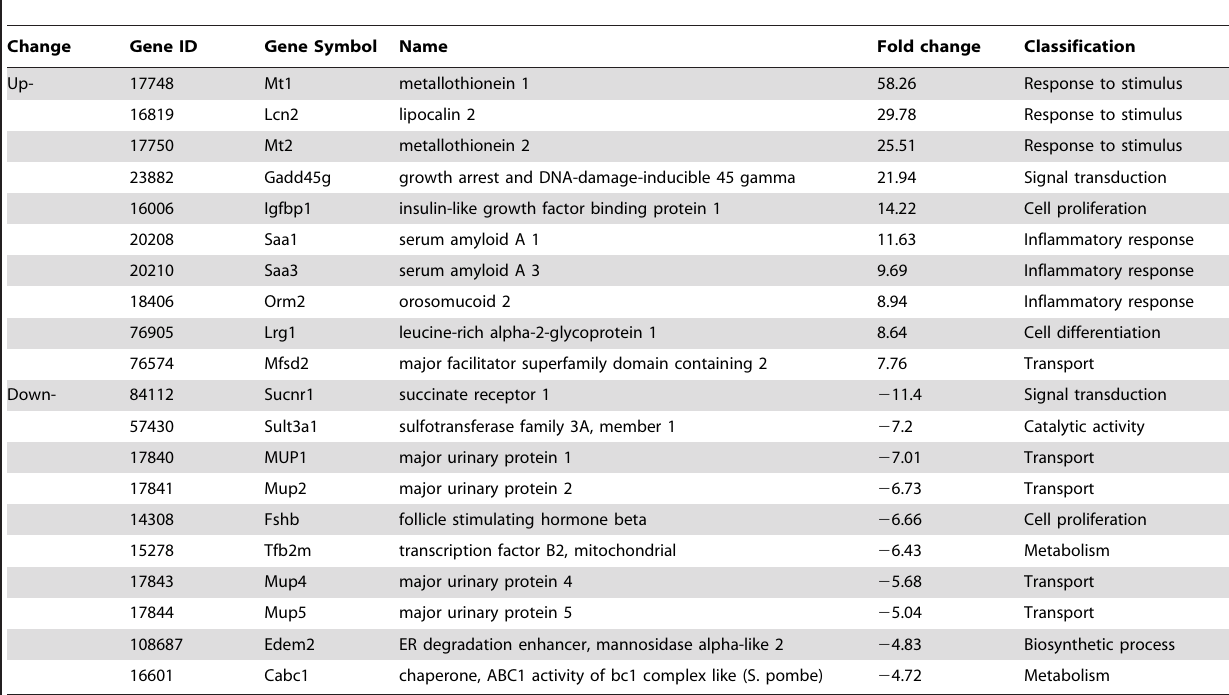
Table 4. Top 10 up-regulated or down-regulated differentially expressed genes and their GO clustering classification at 6 months after intrahepatic injection of E.multilocularis metacestode (infected mice), compared to intrahepatic injection of saline (non-infected mice).